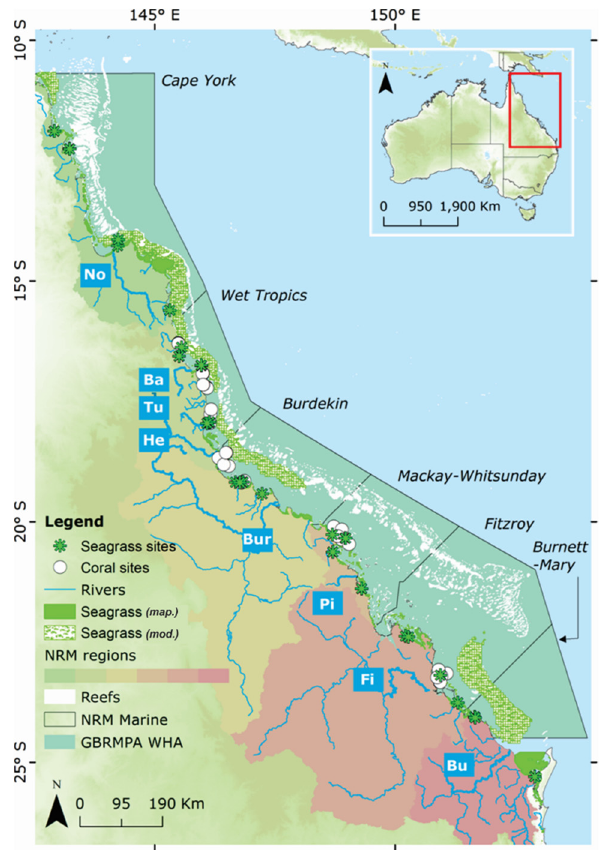
Figure 1. The GBR (Great Barrier Reef) World Heritage Area, Natural Resource Management (NRM) regions and marine portions, and major rivers (Normanby: No, Barron: Ba, Tully: Tu, Herbert: He, Burdekin: Bur, Pioneer: Pi, Fitzroy: Fi and Burnett: Bu). Key marine ecosystems: coral reefs and seagrass meadows. Coral reef outlines used are per the GBR Marine Park Authority Spatial Data Centre official reefs spatial data layer 2013. Seagrass areas show where meadows boundaries have been mapped (map: composite of surveyed data as at November, 1984–June, 2010) and the modelled (mod.) probability (50%–100%, pixel size 2 km 2 ) of deepwater seagrass habitat [17]. The seagrass and coral reef sites monitored though the Great Barrier Reef Marine Monitoring Program are indicated with green asterisks and white dots, respectively.